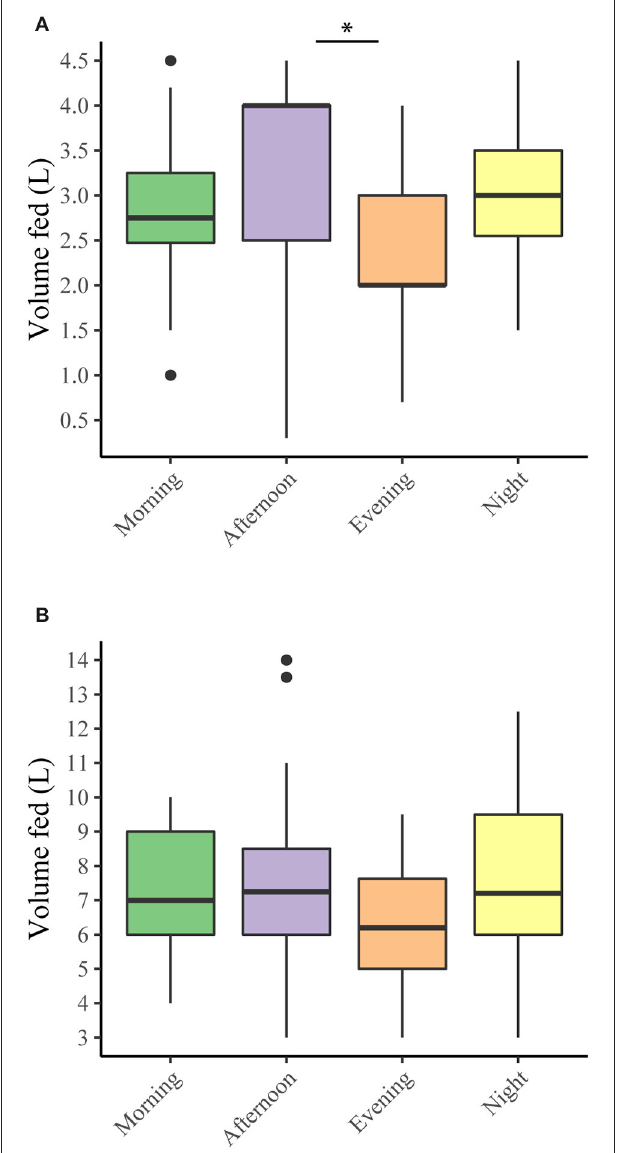
FIGURE 3 | Volume of colostrum fed per calving time. (A) : The volume fed at first feeding ( n = 89), (B) : The total volume of colostrum fed over three feedings ( n = 84). * p < 0.05 (Wilcoxon rank sum